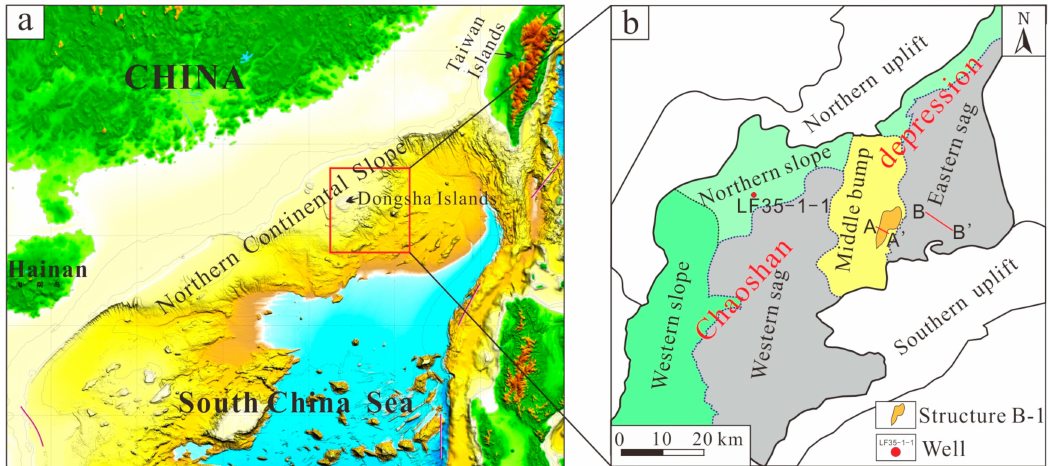
Figure 1. Location and Mesozoic tectonic division of the study area (( a ). location of the study area; ( b ). Mesozoic tectonic division of Chaoshan depression).